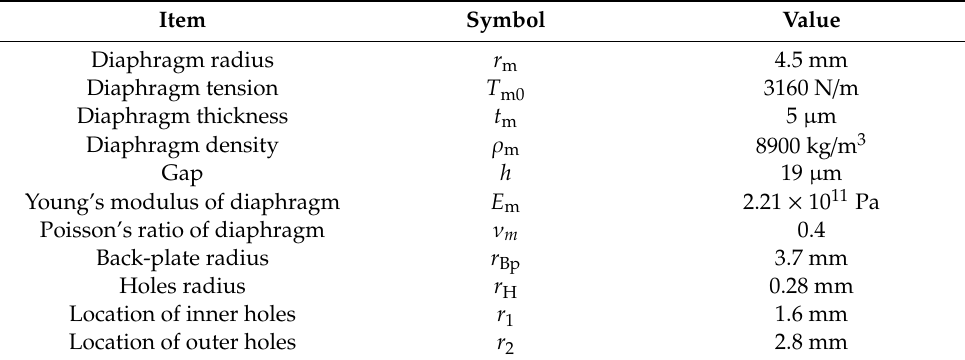
Table 2. Properties of a microphone.